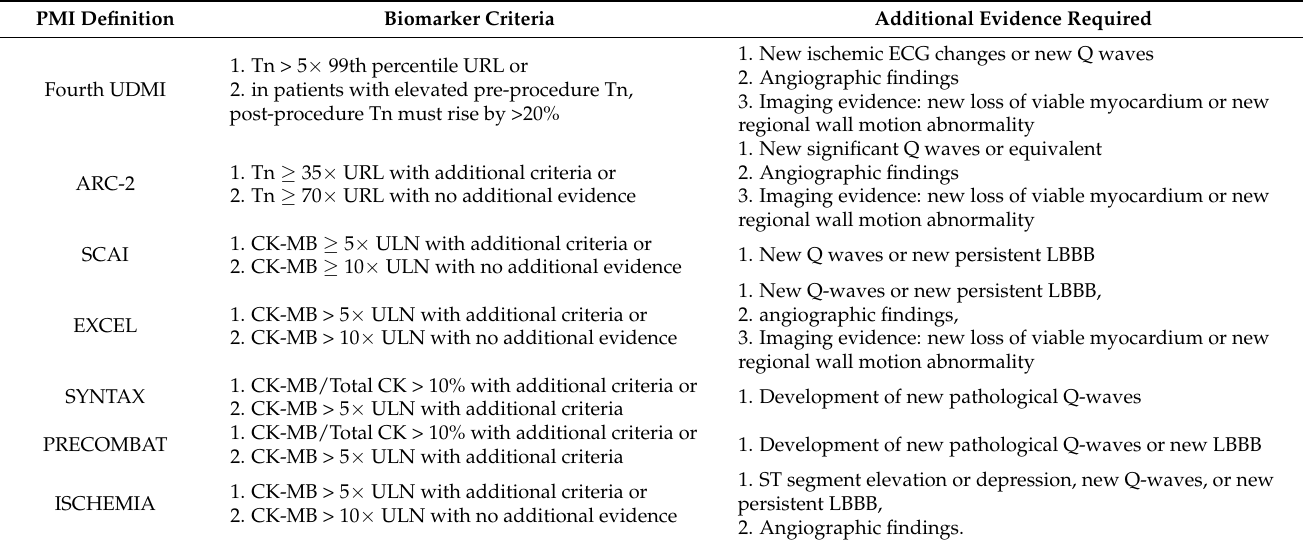
Table 1. Periprocedural myocardial infarction